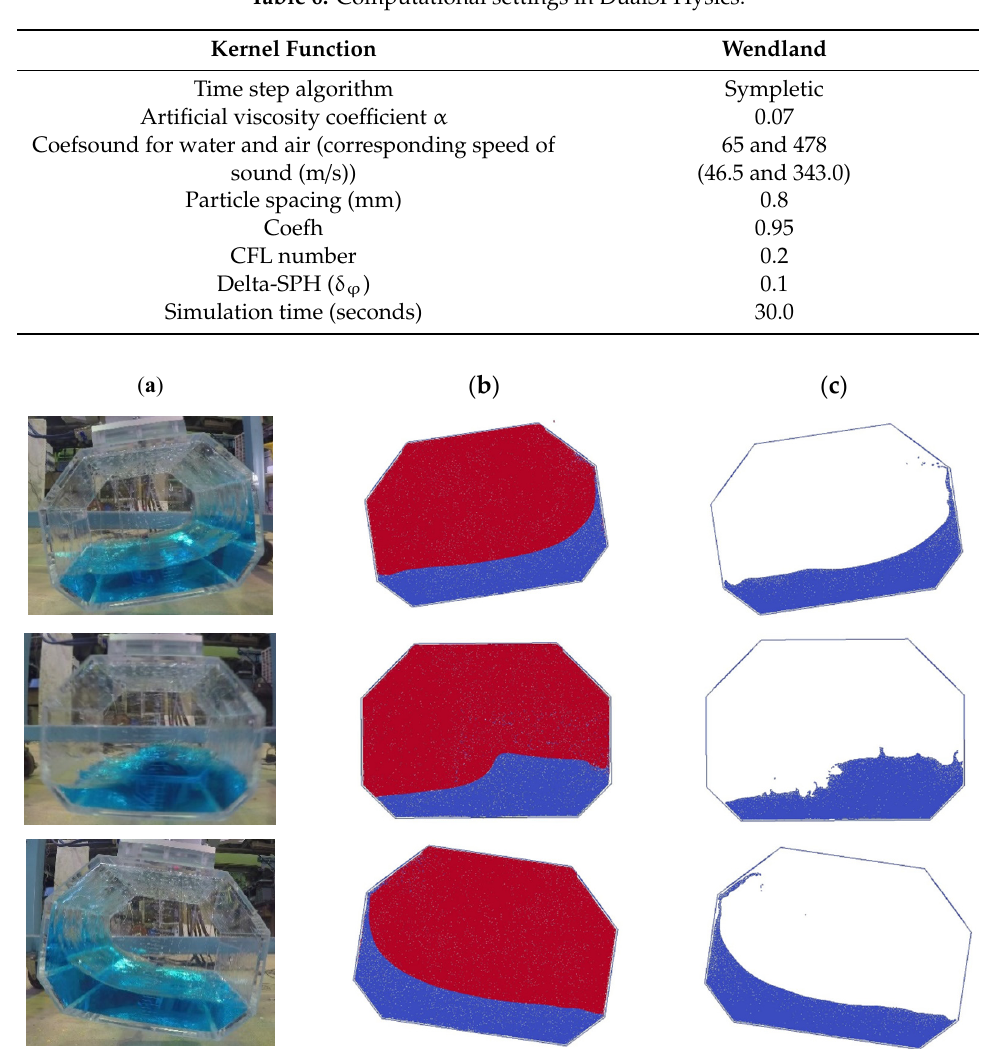
Figure 11. Free surface evolution under roll oscillation in ( a ) the experiment, ( b ) two-phase SPH, and ( c ) single-phase SPH with a filling ratio of 25% at t = 11.0 s, 11.2 s, and 11.4 s.